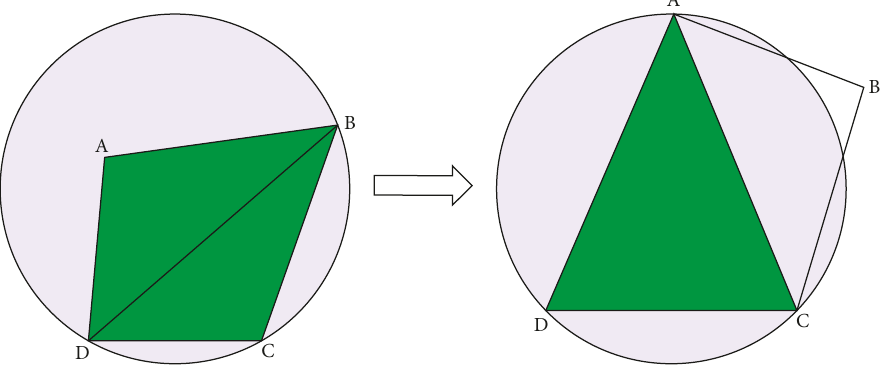
Figure 3: Locally optimized the process.